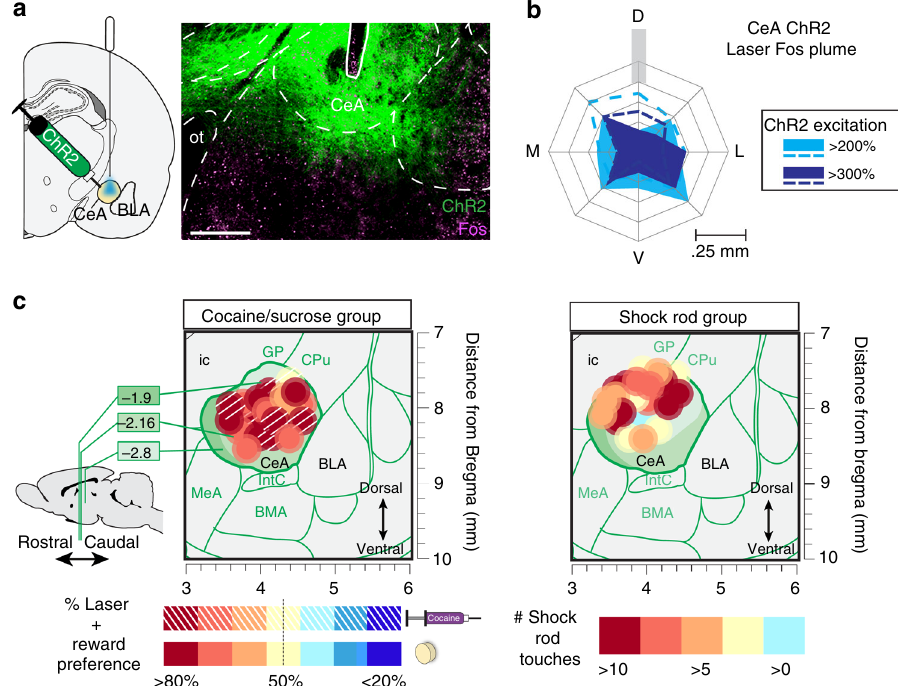
Fig. 1 CeA ChR2 virus and Fos plumes. a CeA photomicrograph (×10 magni fi cation) shows green channelrhodopsin (ChR2) virus infection (AAV5-hSyn- ChR2-eYFP) and magenta Fos protein ( N = 16 rats; ot: optic tract; scale bar: 0.5 mm). b Average Fos plume in CeA-mapped ChR2 rats after laser illumination (>200% above mean eYFP control baseline: light solid blue, >200% above normal unoperated tissue baseline: light blue dashed lines; >300% above eYFP: dark solid blue, >300% above baseline: dark blue dashed lines; D: dorsal, M: medial, L: lateral, V: ventral). See also Supplementary Fig. 1. c Mapped CeA sites of optic fi ber implants for each ChR2 rat in cocaine/sucrose group and in shock-rod group (coronal view). Size of each site symbol re fl ects size of Fos plumes. Symbol colors in sucrose – cocaine group represents the percentage preference for individual ’ s laser-paired sucrose/cocaine reward over alternative reward. For Shock-Rod Group, symbol color represents individual ’ s number of shock-rod touches on day 3. Ic, internal capsule; GP, globus pallidus; CPu, caudate putamen; BLA, basolateral amygdala; IntC, intercalated amygdala; MeA, medial amygdala; BMA, basomedial